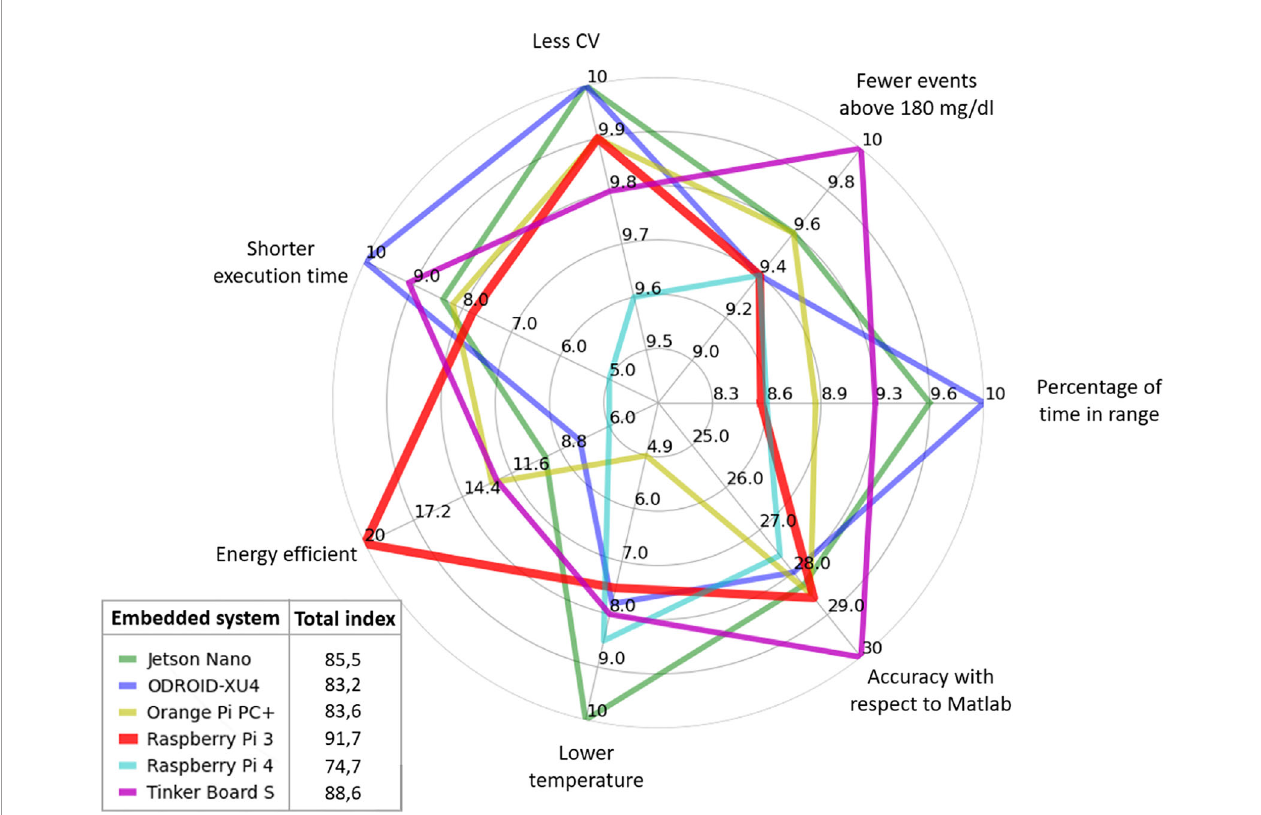
FIGURE 10 | Weighting obtained by each embedded system in the performance